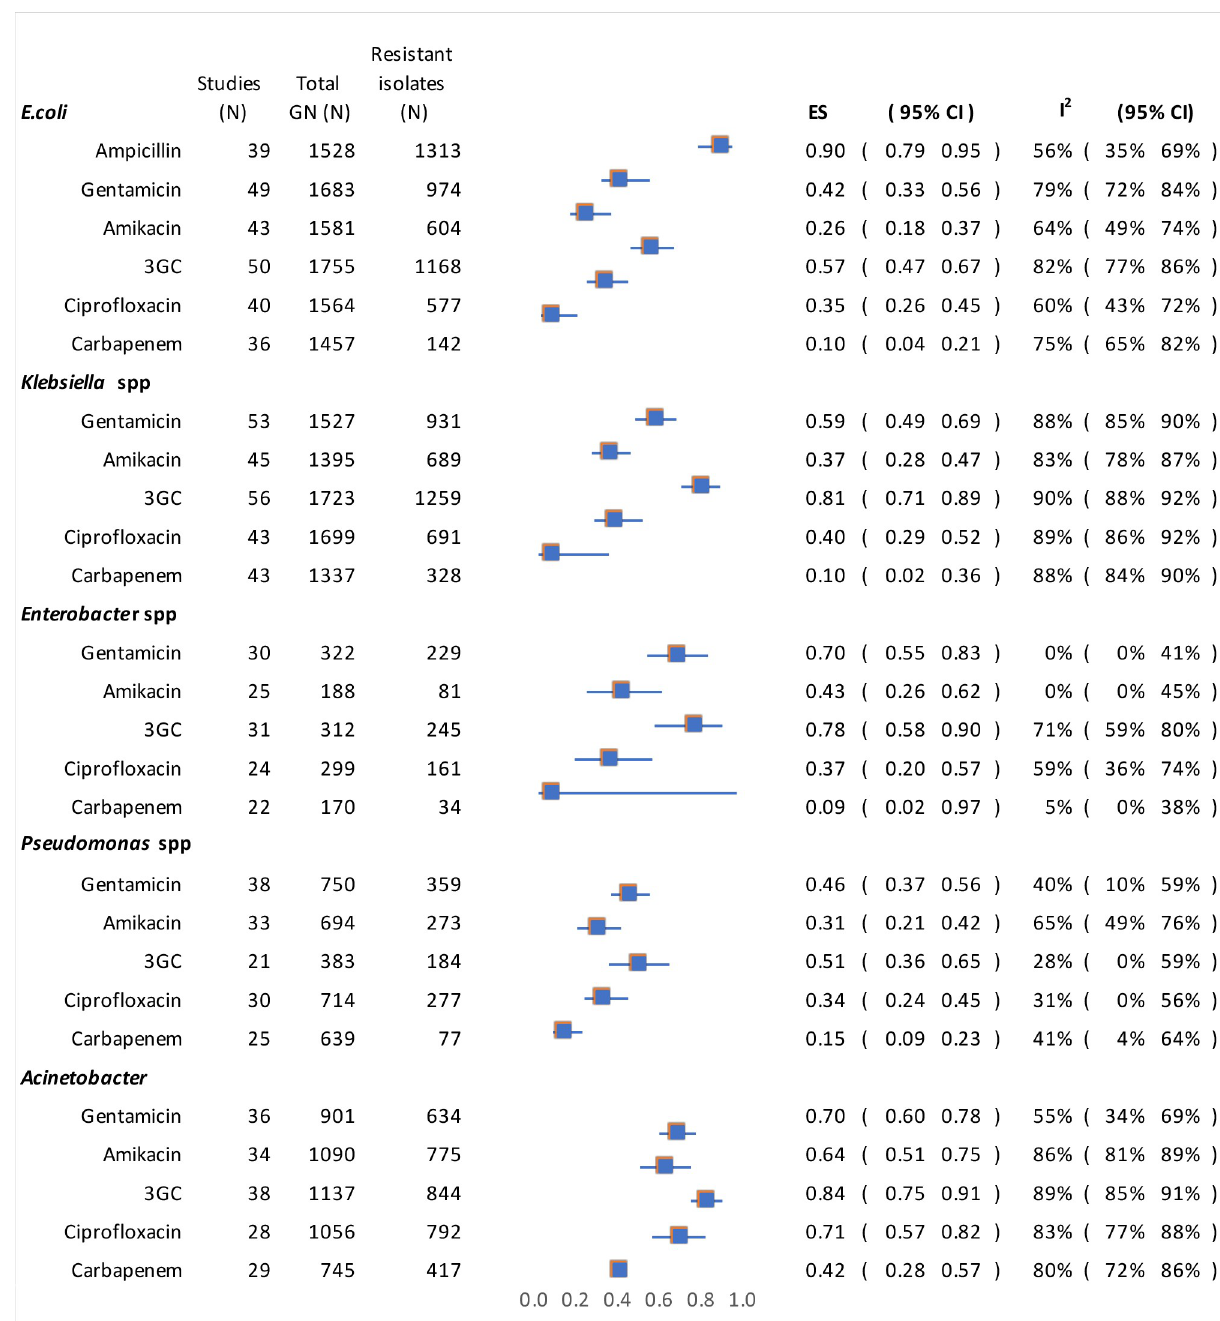
Fig 4. Pooled prevalence of antimicrobial resistance. 3GC, third-generation cephalosporin; ES, effect size; GN, Gram-negative.